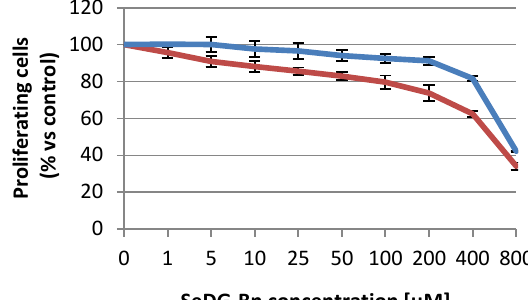
Figure 4. Dose–response curve on WM266 (red) and HDF (blue) cells. Cells were treated with SeDG- Bn at indicated concentrations and incubated for 48 h. The results are presented as the percentage of proliferating cells with respect to the control and are expressed as means ± SE of at least three independent experiments performed in triplicate. WM266: p < 0.05: at 6, 12, and 200 µ M, p < 0.01 at other concentrations; HDF: p < 0.05 from 200 to 800 μ M.